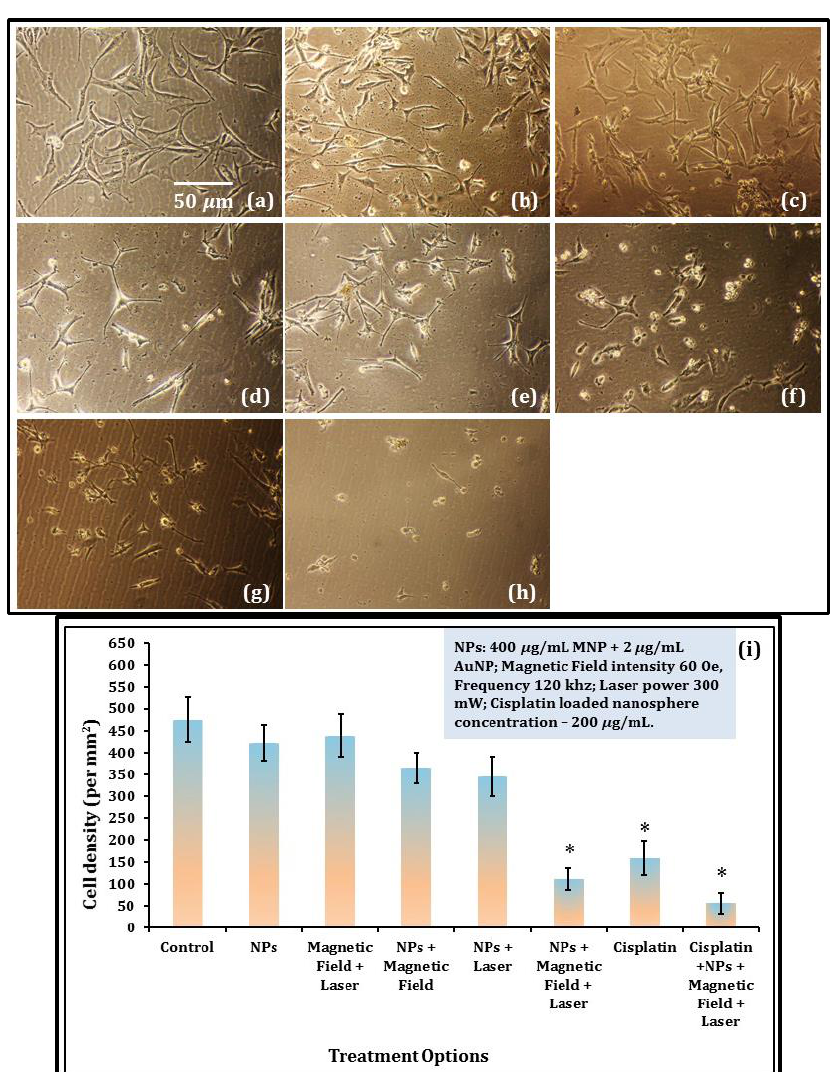
Figure 4. B35 neuroblastoma cell proliferation under the following conditions: ( a ) control; ( b ) presence of NPs (400 µg/mL MNP + 2 µg/mL AuNP) in the culture media; ( c ) combined optical-AC magnetic field irradiation in the absence of NPs; ( d ) presence of NPs under AC magnetic field irradiation; ( e ) presence of NPs under optical irradiation; ( f ) combined optical-AC magnetic field irradiation in the presence of NPs; ( g ) presence of 200 µg/mL CPNPs; and ( h ) combined optical-AC magnetic field irradiation in the presence of NPs and CPNPS. The AC magnetic field intensity was 60 Oe, frequency was 120 kHz, and laser power was 300 mW (at 520 nm). Scale bar is 50 µm in ( a ), and is also applicable for ( b – h ). ( i ) Bar chart displaying quantification of average cell densities (cell number/mm 2 ), indicative of cell proliferation for B35 neuroblastoma cells under all treatment options. Data are means ± SEM from four separate experiments and * indicates statistically significant differences, compared to cells cultured as the control, at p < 0.01 (ANOVA and LSD post-hoc).